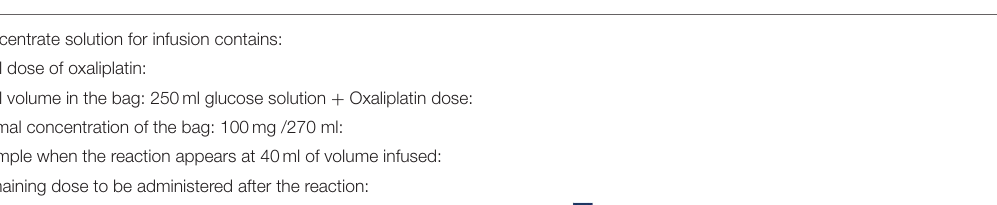
TABLE 1 | Example of the protocol used for the Same-day desensitization, using a non diluted 1 bag/10 step protocol, based on the protocol published by Sala-Cunill et al. (17). Example of dosing for 100mg of